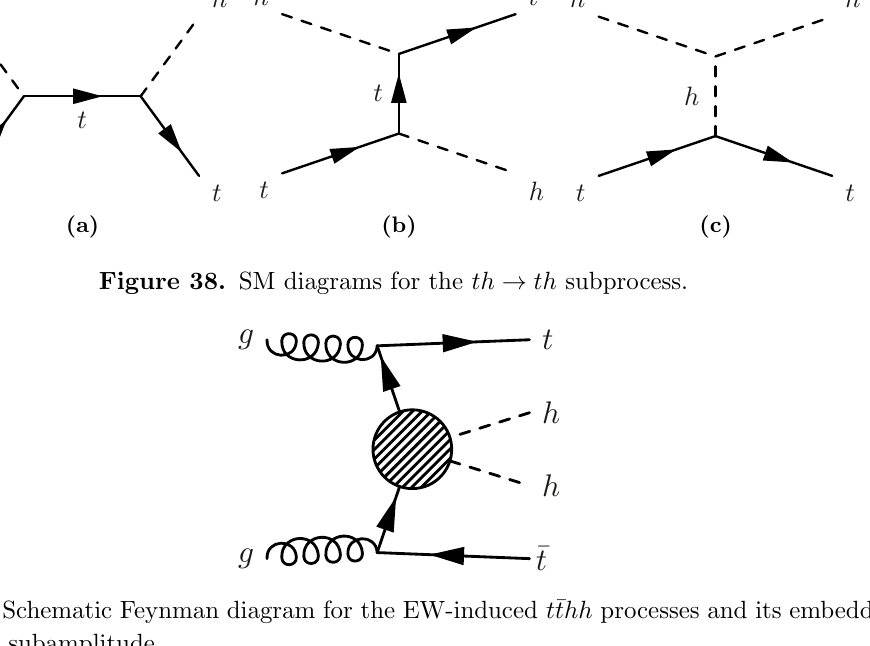
Figure 39. Schematic Feynman diagram for the EW-induced t (cid:22) thh processes and its embedding of the t h t h !